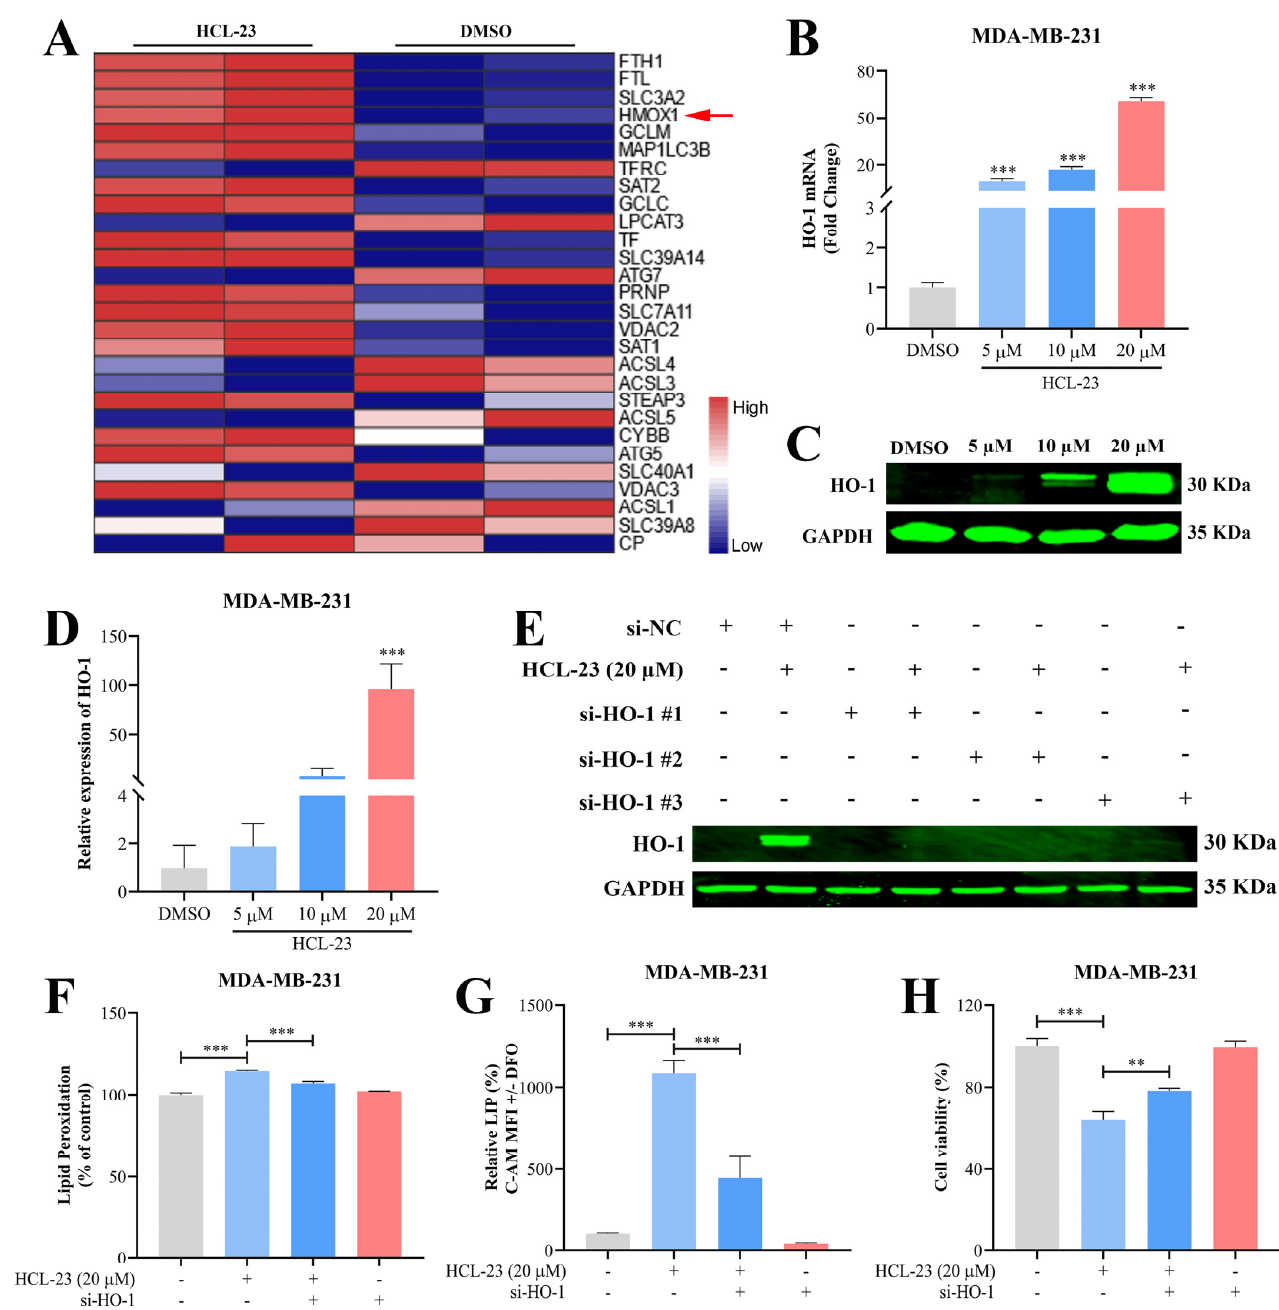
Figure 7. HCL-23 induces ferroptosis by up-regulating HO-1 expression. ( A ) Heat map of ferroptosis-related genes in response to HCL-23 treatment using RNA-seq analysis. Low expression is depicted in blue, and high expression is depicted in red. ( B ) The mRNA level of HO-1 was measured by qRT-PCR after treatment with different concentrations of HCL-23 for 24 h. ( C ) The protein level of HO-1 was analyzed by Western blot in MDA-MB-231 cells treated with HCL-23 for 24 h. ( D ) Quantification of HO-1 protein expression. ( E ) Western blot was used to detect the protein level of HO-1 in MDA-MB-231 cells treated with HCL-23 and transfected with specific siRNA for HO-1. ( F ) HCL-23 (20 µM) increased the level of lipid peroxidation in MDA-MB-231 cells, which could be partly neutralized by si-HO-1 #1 transfection. ( G ) HO-1 knockdown reversed the increased level of LIP induced by HCL-23 (20 µM) in MDA-MB-231 cells. ( H ) si-HO-1 counteracted HCL-23-induced inhibition of cell viability. Data represent the mean ± SD of three independent experiments. ** p < 0.01, *** p < 0.001 vs. the DMSO group.